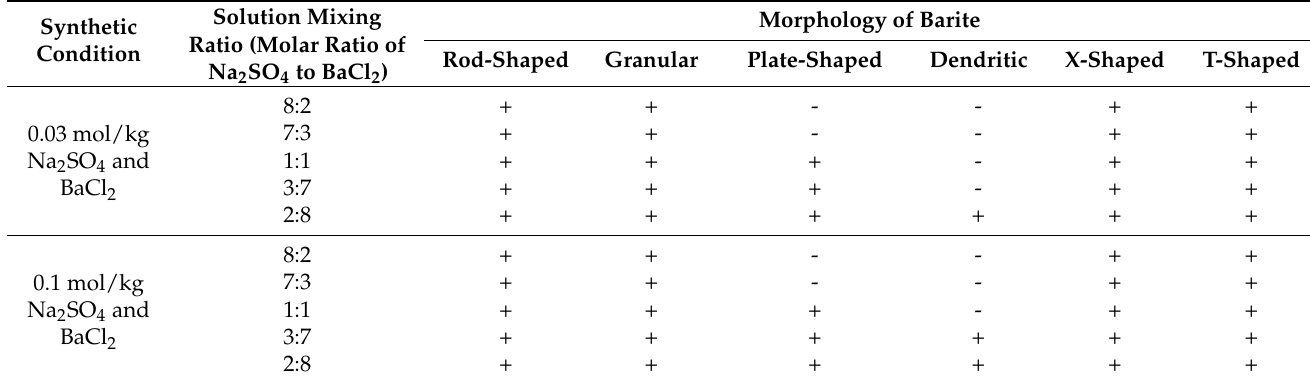
Table 2. The morphological statistics of barite appearing in a mixed solution of barium salt and sulfate with different ratios at 200 ◦ C.